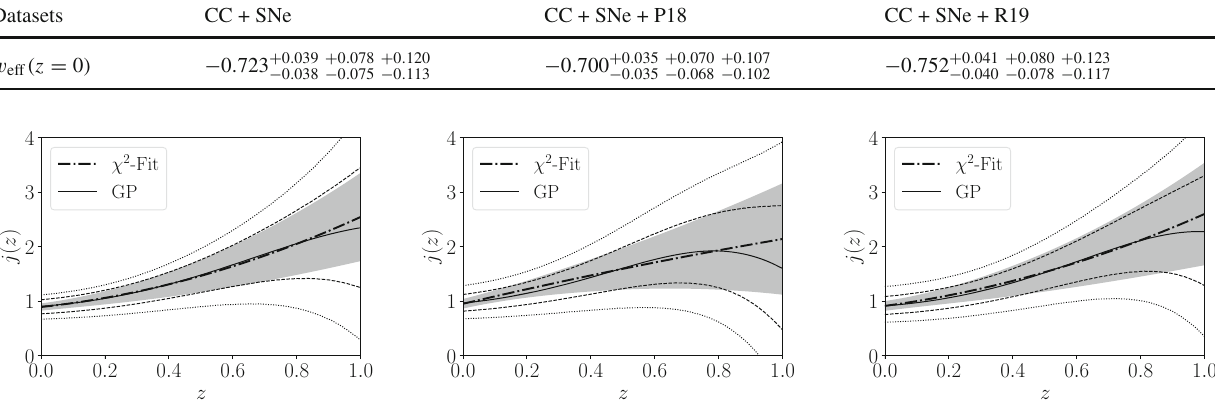
Table 6 Table showing the reconstructed value along with the 1 σ , 2 σ and 3 σ uncertainty of w eff ( 0 ) corresponding to the different datasets used Datasets